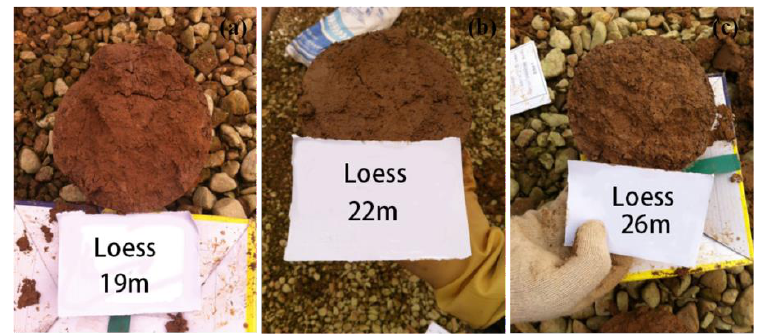
Figure 11. Loess samples of different depths after water shutdown, ( a ) 19 m depth, ( b ) 22 m depth,